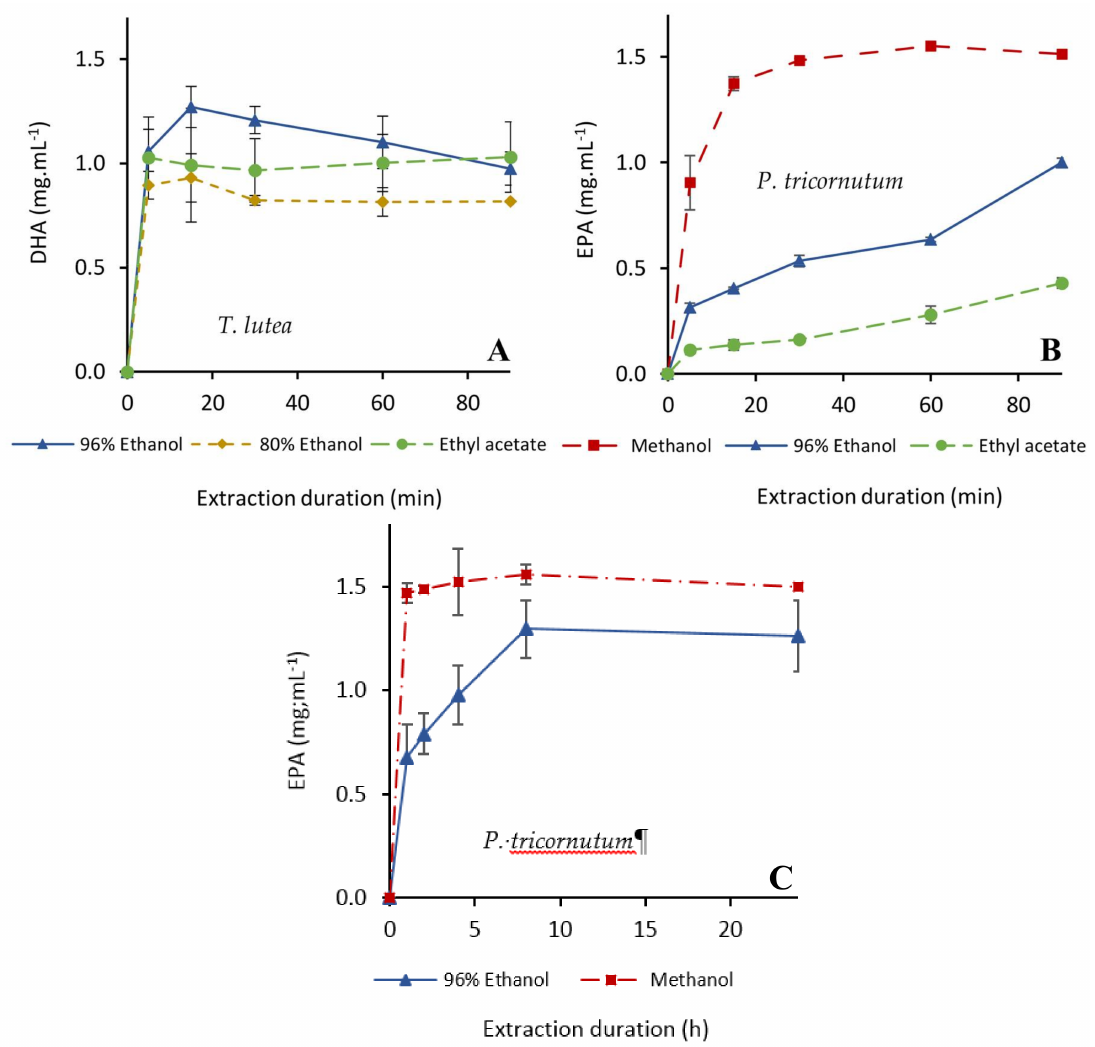
Figure 3. Kinetics of extraction of docosahexaenoic acid (DHA) from T. lutea ( A ) and eicosapentaenoic acid (EPA) from P. tricornutum ( B ) with ethanol (80 or 96%), methanol (100%) and ethyl acetate (100%). Extractions were carried out from freeze dried biomass for 90 min at 30 ◦ C ( A , B ) and for 24 h at 40 ◦ C ( C ) with a 20:1 ( v / w ) solvent/biomass ratio in a closed system with magnetic stirring ( n = 3